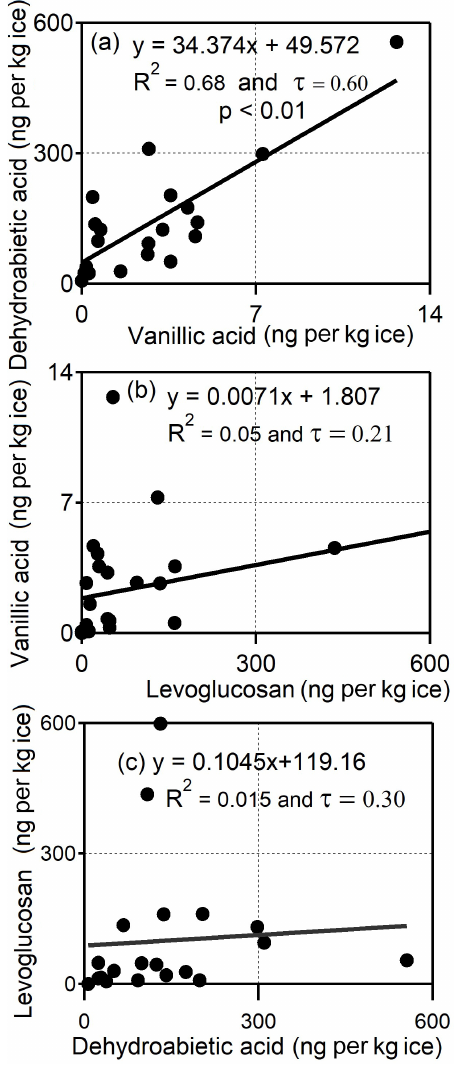
Figure 5. Correlation (Pearson: R 2 ; Kendall: τ ) plots between the concentrations of (a) dehydroabietic and vanillic acids, (b) vanil- lic acid and levoglucosan, and (c) levoglucosan and dehydroabietic acid. In (b, c) , correlations are insignificant in the Alaskan ice core records from the saddle of Aurora Peak after the Great Pacific Cli- mate Shift